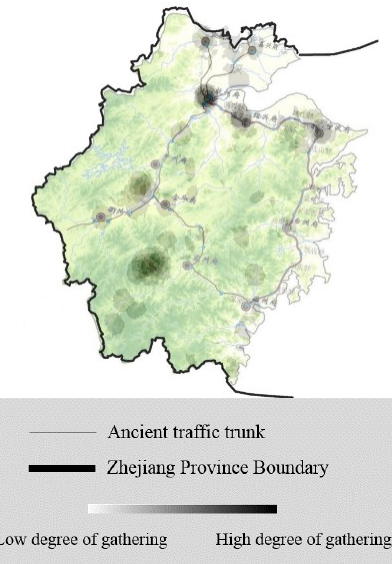
Figure 5. Gathering Map of Culture Resources Density and Districts in Six